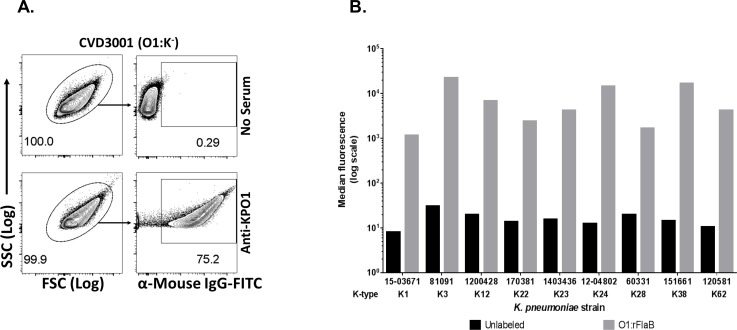
Binding by O1 conjugate induced antibodies to KP O1 OPS isolates expressing different capsule types.Sera from mice immunized with O1:rFlaB (anti-KPO1) were incubated with different KP isolates and binding was assessed by flow cytometry using fluorescently labeled (FITC) secondary detection antibody. KP incubated with FITC labeled KP alone (in the absence of serum) was used as control. (A) Forward scatter (FSC)/ side scatter (SSC) plots are shown for CVD 3001 as a representative for the group, indicating the selected population for analysis (left), and SSC/ FITC analyses of CVD 3001. Selected population percentages are indicated. (B) A panel of KP O1 clinical isolates from UMMC were assessed as above. The mean fluorescence intensity for bacteria labeled with conjugate sera (O1:rFlaB) over background (Unlabeled) is indicated.